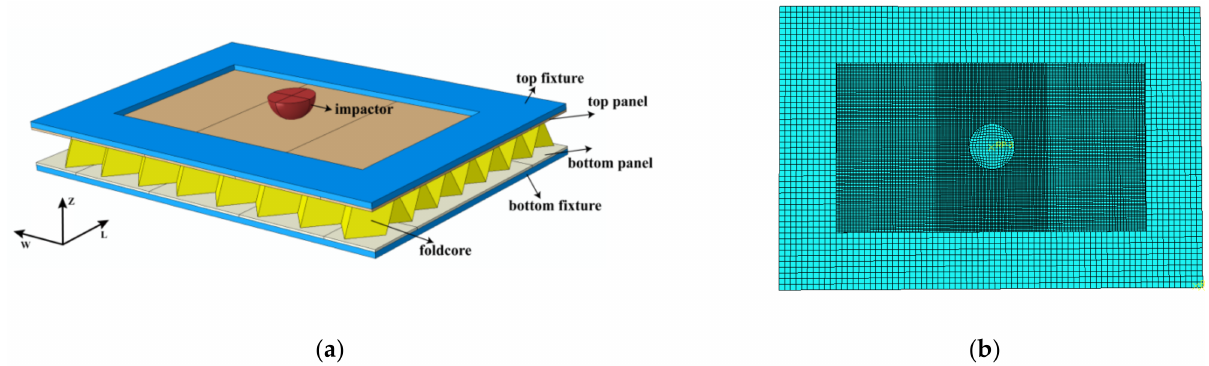
Figure 2. FE model of aluminum folded sandwich structure. ( a ) Assembly drawing of the structure; ( b ) Top view of the structure after